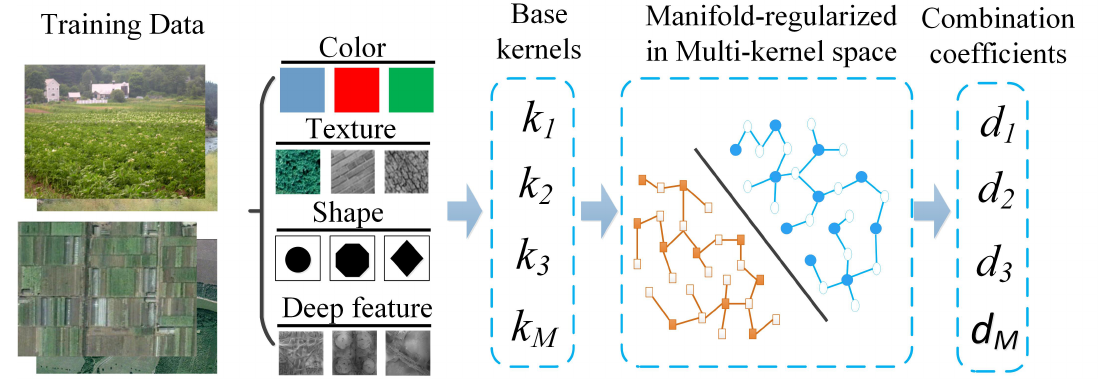
Figure 3. Illustration of multiple kernel learning and manifold